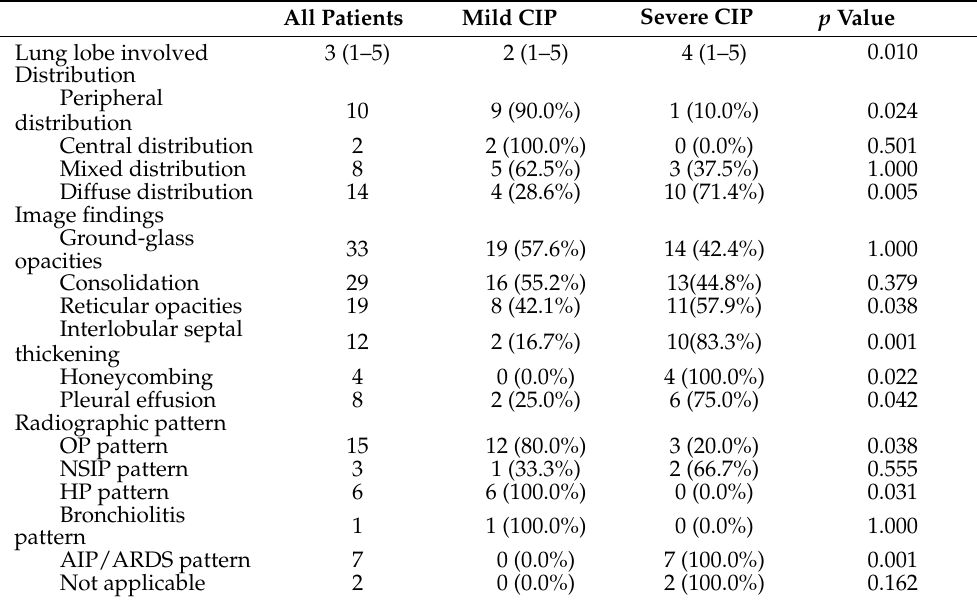
Table 2. Radiological features by